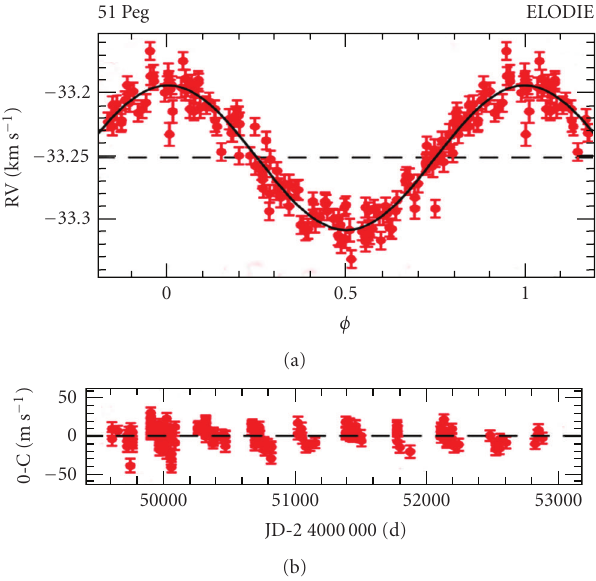
Figure 3: Radial velocity curve for 51 Peg where the first exoplanet was detected in 1995 by Mayor and Queloz [5,